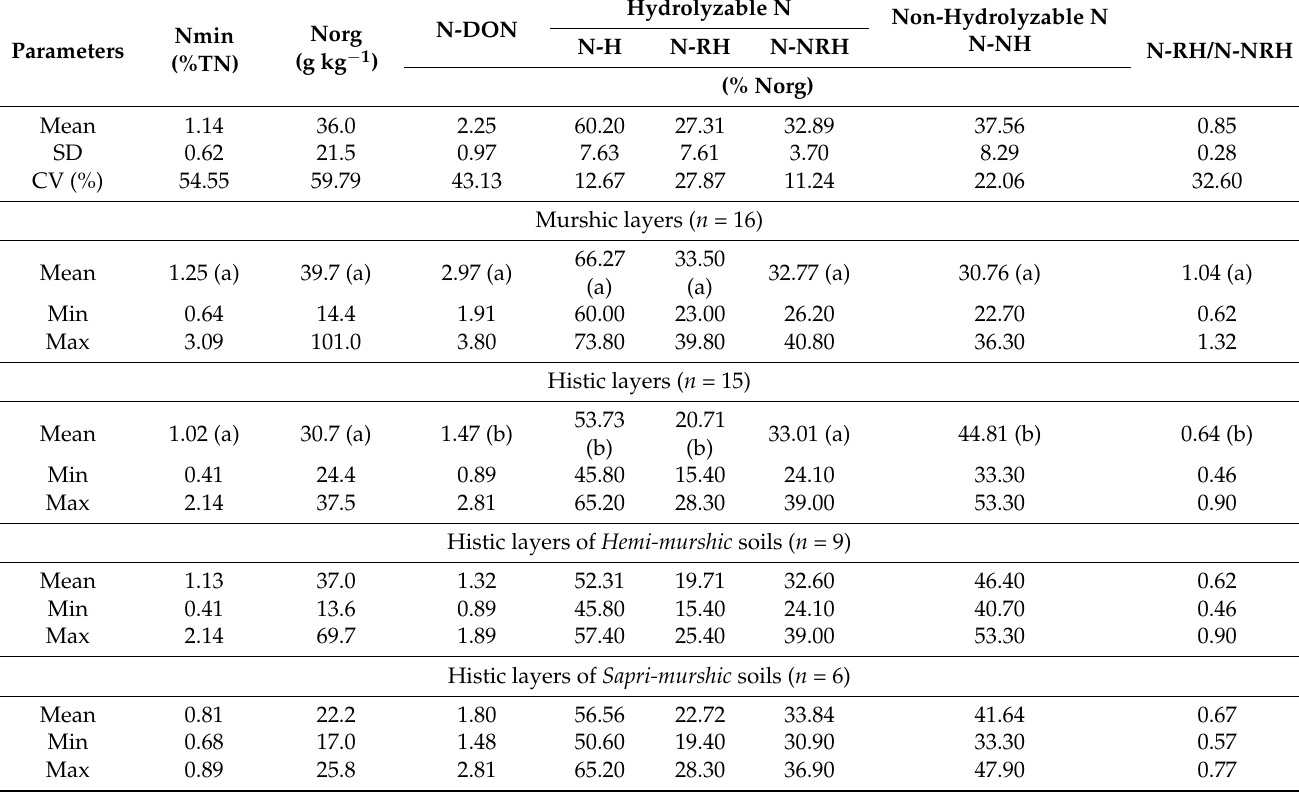
Table 7. Values of descriptive statistics of the separated nitrogen